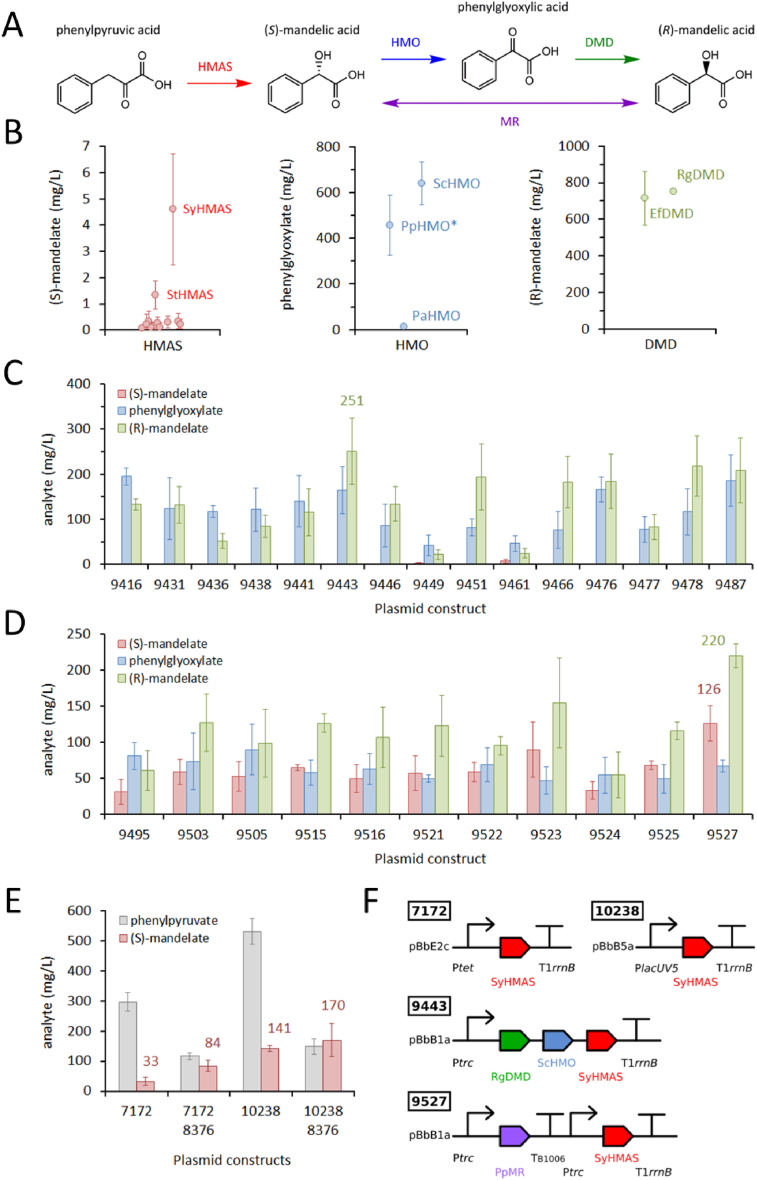
(A) Pathways from phenylpyruvate to the (S)- and (R)-enantiomers of mandelate. Enzyme abbreviations: HMAS (hydroxymandelate synthase); HMO (hydroxymandelate oxidase); DMD (D-mandelate dehydrogenase); and MR (mandelate racemase). (B) Screening enzyme candidates. HMAS candidates expressed from the pBbE2c plasmid in DH10β cells fed 3 mM phenylpyruvate. SyHMAS (Streptomyces yokosukanensis) was the best performing enzyme. HMO and DMD candidates were screened in cell lysates fed 3 mM (S)-mandelate or phenylglyoxylate respectively. ScHMO (Streptomyces coelicolor) and RgDMD (Rhodotorula graminis) were selected as the best performing enzymes. (C) Screening (R)-mandelate pathway constructs in DH5α mutants (ΔtyrR,ΔtyrA). After 24 h, plasmid SBC009443 produced 251 mg/L (R)-mandelate with no detectable (S)-mandelate. (D) Screening (R/S)-mandelate pathway constructs in DH5α mutants (ΔtyrR,ΔtyrA). After 24 h, plasmid SBC009527 produced (R)- and (S)-mandelate at 220 and 126 mg/L, respectively (27% e.e.). (E) Final (S)-mandelate titre screen. SyHMAS was subcloned from pBbE2c (SBC007172) into pBbB5a (SBC010238) and screened in DH5α mutants (ΔtyrR,ΔtyrA) with or without the SBC008376 plasmid to boost phenylpyruvate production (Fig. S2). (F) Best performing plasmid constructs. PpMR (MR from Pseudomonas putida).